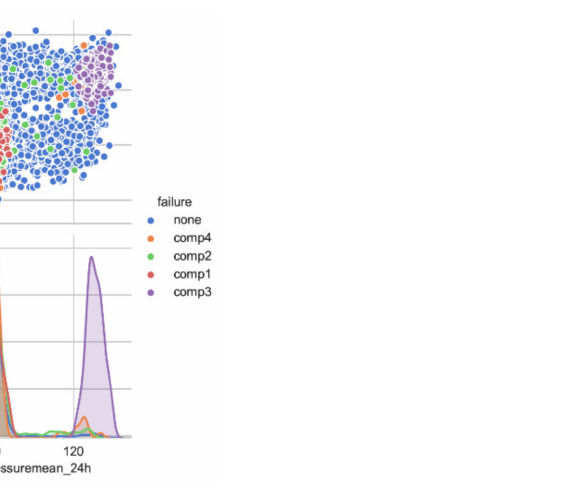
Figure 9. Detailed analysis of the correlation between features pressuremean_3h and pressure- mean_24h.